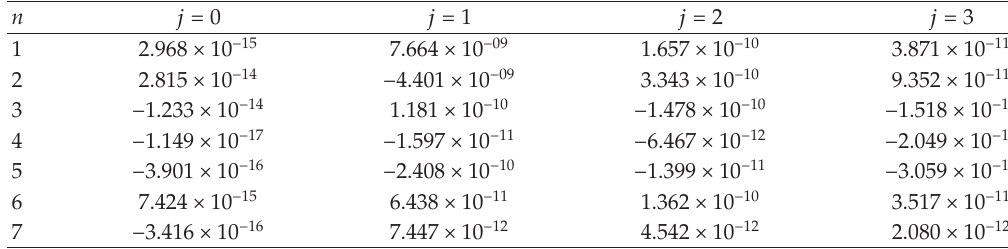
Table 3: Phases p